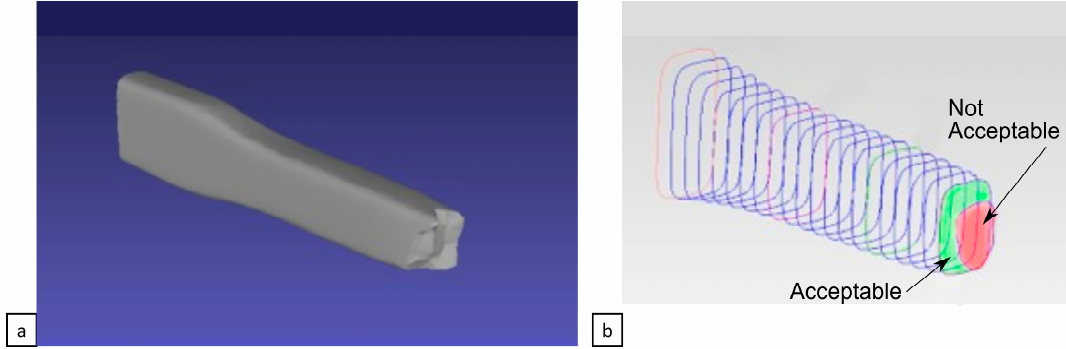
Figure 5. Example of cross ‐ section measurement, using the 3D structured light scanner: ( a ) acquired and reconstructed 3D shape; ( b ) cross ‐ sections evaluated through a MATLAB routine.